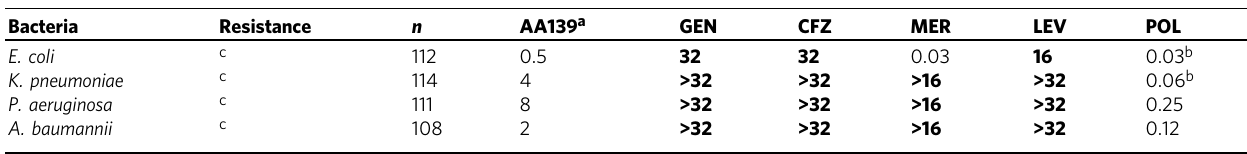
Antimicrobial activity of AA139 and comparator antibiotics against Gram-negative bacterial panels is displayed as MIC 90 μ g mL − 1 . Top: 331 isolates selected from US isolates 2010 – 2012 panel; bottom: 445 isolates selected from worldwide isolates 2011 – 2013 panel. Source data are provided as a source data fi le. MIC in bold indicates resistance (CLSI breakpoints). S susceptible, MDR resistant to 3 – 4 classes, XDR resistant to >4 classes, CFZ ceftazidime, CIP cipro fl oxacin, COL colistin, GEN gentamycin, LEV levo fl oxacin, MER meropenem, POL polymyxin B. a No breakpoints de fi ned.